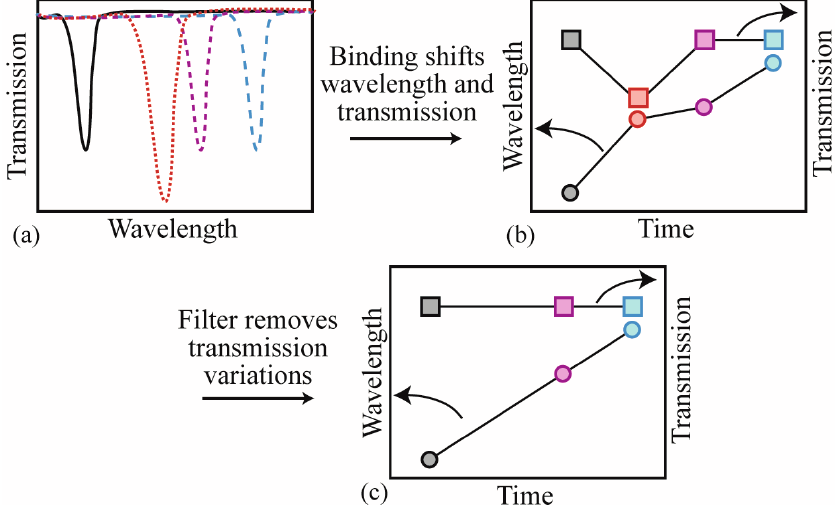
Figure 3. Image of the data analysis path. ( a ) The resonant wavelength red-shifts as proteins bind on the surface. Additionally, the transmission changes due to coupling instabilities; ( b ) if the four results in part (a) are re-plotted on a dual y-axis graph, the relationship between the wavelength and the transmission becomes apparent. Additionally, it